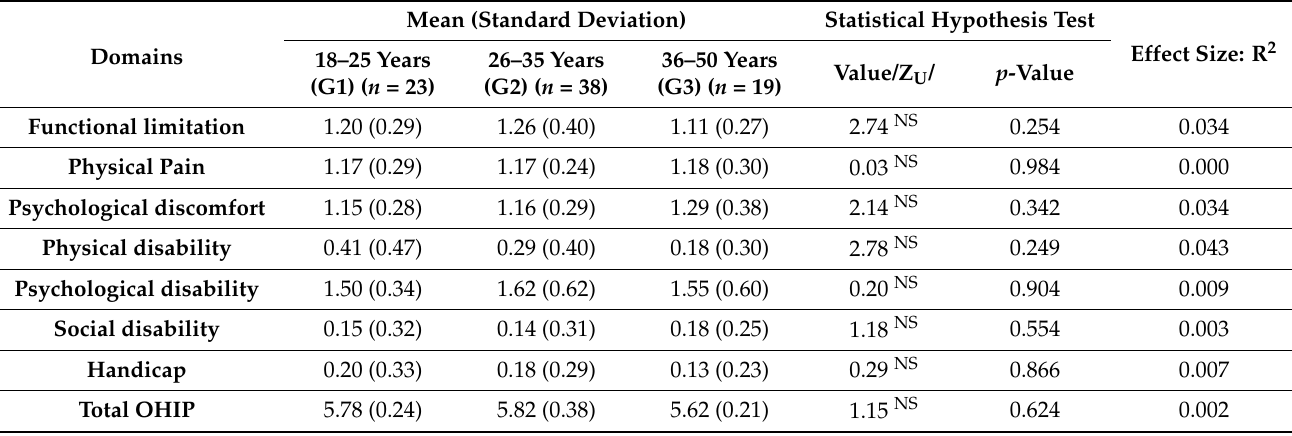
Table 4. Differences in the domains of the OHIP-14 questionnaire as a function of age ( n =